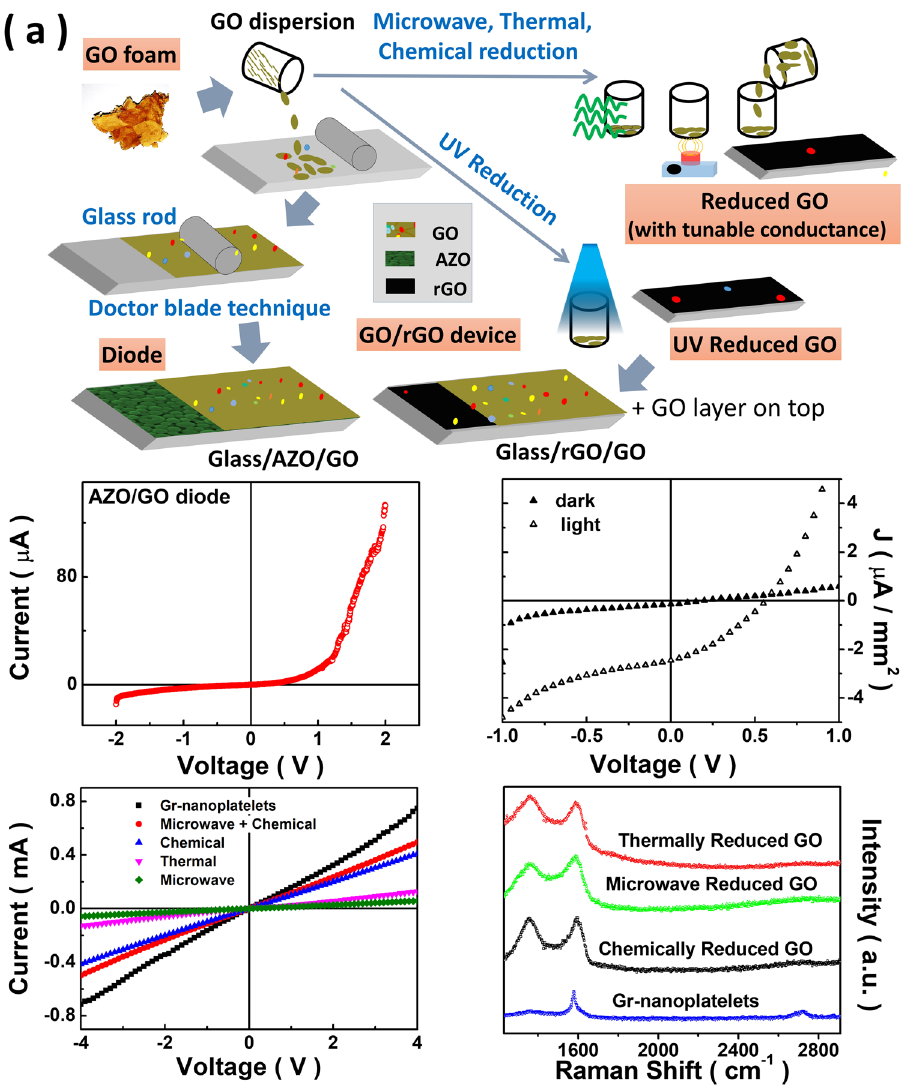
Figure 7. ( a ) Schematic diagram summarizing the typical applications demonstrated using the as synthesized GO material (dried GO foam). The actual optical image of a piece of dried GO foam obtained after vacuum desiccation of the as grown GO sample is also shown within the schematic. The GO films deposited on AZO is used for studying diode like behavior while the photovoltaic property is explored in the GO-rGO bilayer. Ultra- violet, microwave, thermal and chemical reduction protocols are used for making rGO samples. ( b ) Current- Voltage (I-V) characteristics of the GO-AZO bilayer. ( c ) Current-Voltage (I-V) characteristics of the GO-rGO bilayer in dark and upon exposure to 1.5AM Global sunlight. ( d ) Current-Voltage (I-V) characteristics of drop-casted films of rGO samples made using different reduction techniques. For a comparison, the I-V characteristics of a drop-casted film of commercially available graphene nanoplatelets is also shown. ( e ) Raman spectra for graphene nanoplatelet sample along with rGO samples made using different